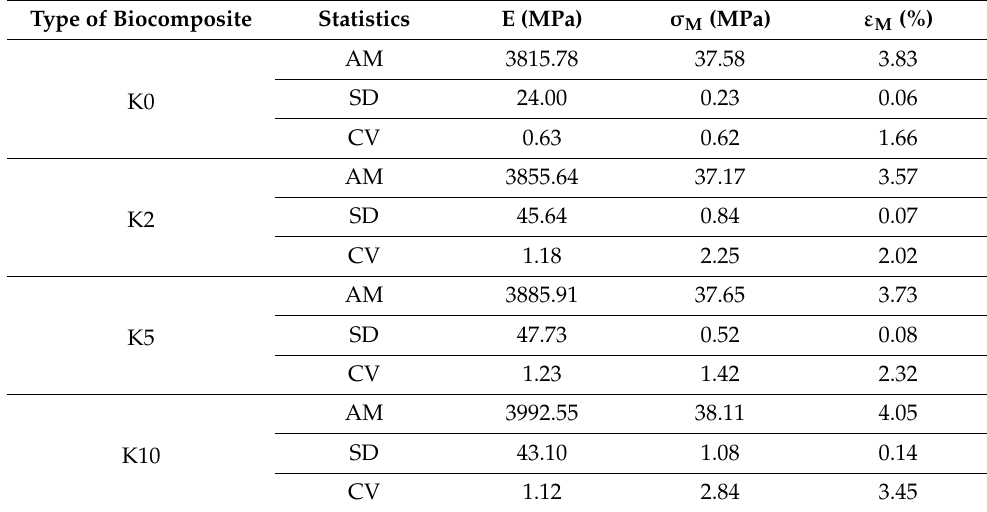
Table 4. Results from the uniaxial tensile test for biocomposites with unmodified hemp fibers and fibers exposed to 2%, 5% and 10% NaOH solution.